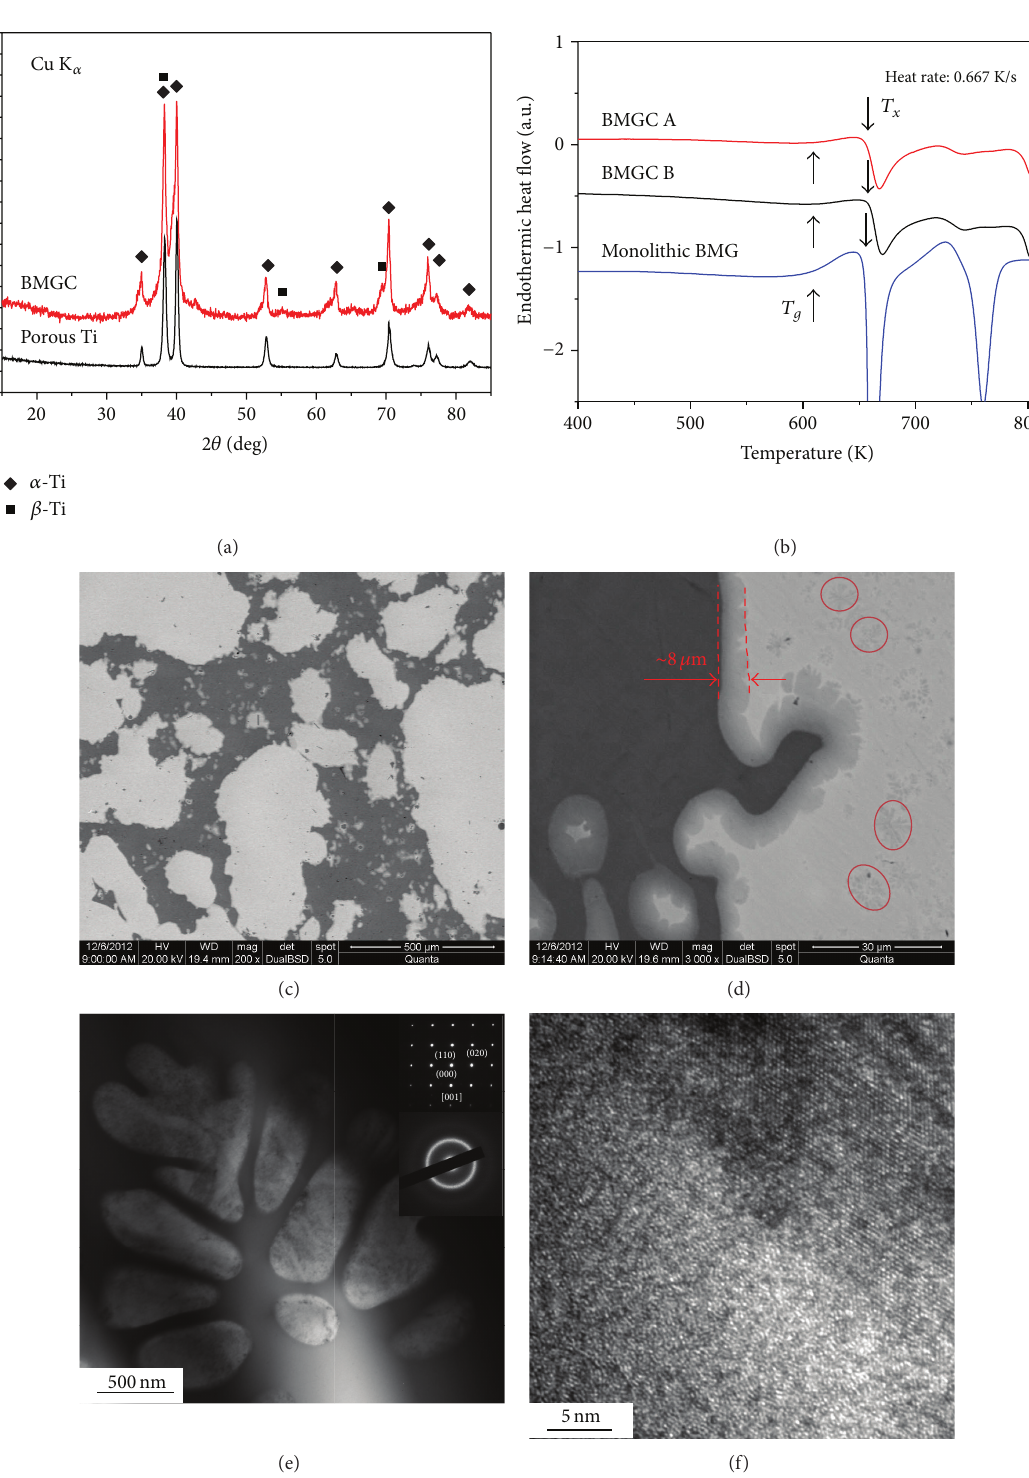
Figure 1: Structural characterizations of Ti/Ti-based-metallic-glass IPC. (a) XRD patterns of the composites and Ti skeleton. (b) DSC curves of the composites and monolithic BMG. (c) and (d) SEM micrographs. (e) and (f) TEM micrographs of